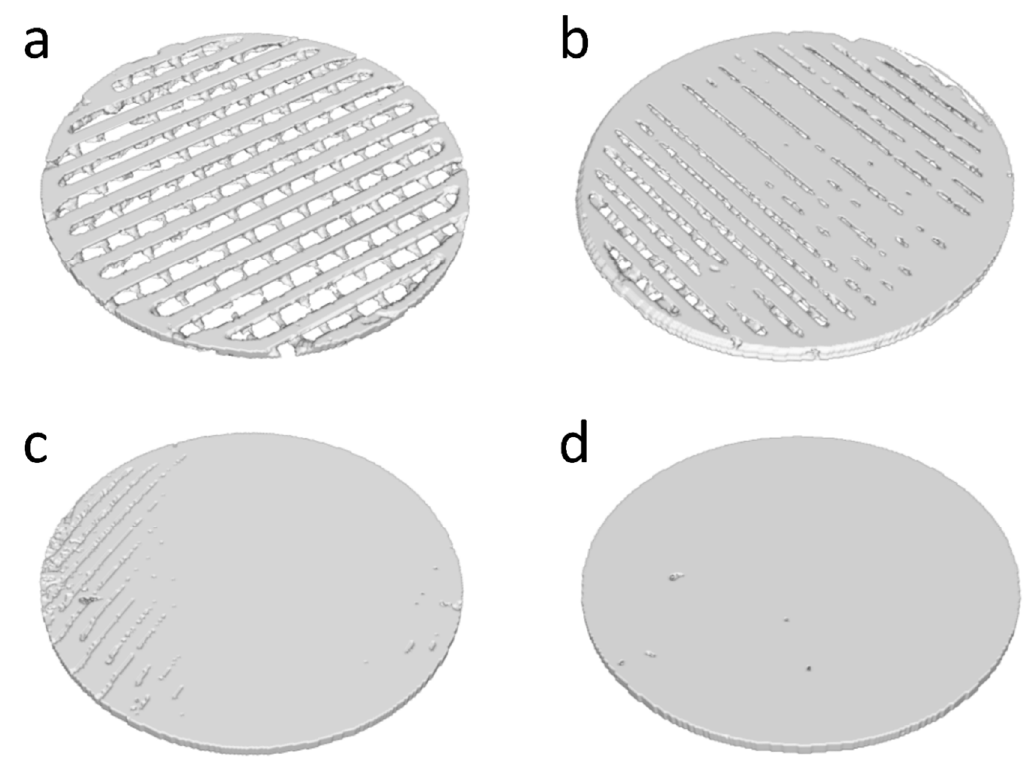
Figure 2. 3D reconstructed µ -CT image of ( a ) LP, ( b ) SP, ( c ) NP, and ( d ) SC membranes. Table 1. Porosity of LP, SP, NP, and SC membranes as determined by µ -CT.